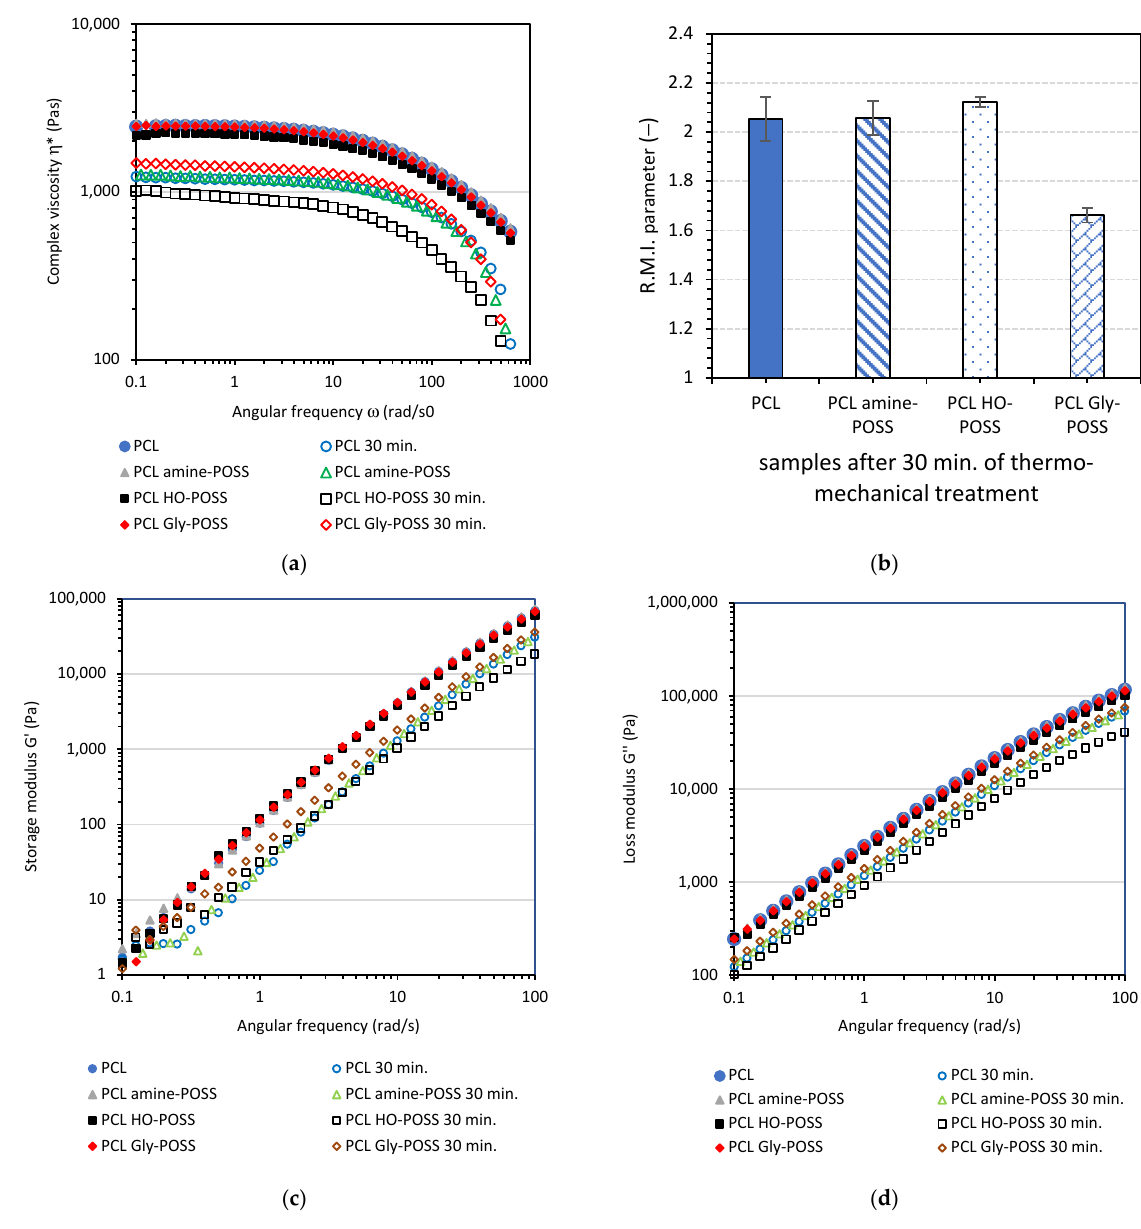
Figure 9. Viscoelastic properties at 100 ° C of PCL modified by the addition of POSS particles, complex viscosity η * ( a ), calculated values of R.M.I. parameter ( b ), storage shear modulus G ′ ( c ), loss shear modulus G ″ ( d ), for PCL samples before and after thermo-mechanical ageing (condition of ageing: temperature 100 ° C, mechanical stress equivalent of 50 s − 1 shear rate, time 30 min). The viscosity Cole-Cole plots, plots of η ″ (out of the phase component of the complex viscosity η *) versus η ′ (dynamic viscosity), are a useful tool to study the influence of the additives on the rheological behavior and the relaxation of the melted polymer. Some rhe- ological parameters that can be derived from the Cole-Cole plots are the zero-shear vis- cosity η 0 and characteristic relaxation time [53–56]. The Cole-Cole plots of the PCL and POSS-PCL samples before and after thermo-mechanical degradation over 30 min at 100 ° C are depicted in Figure 10.